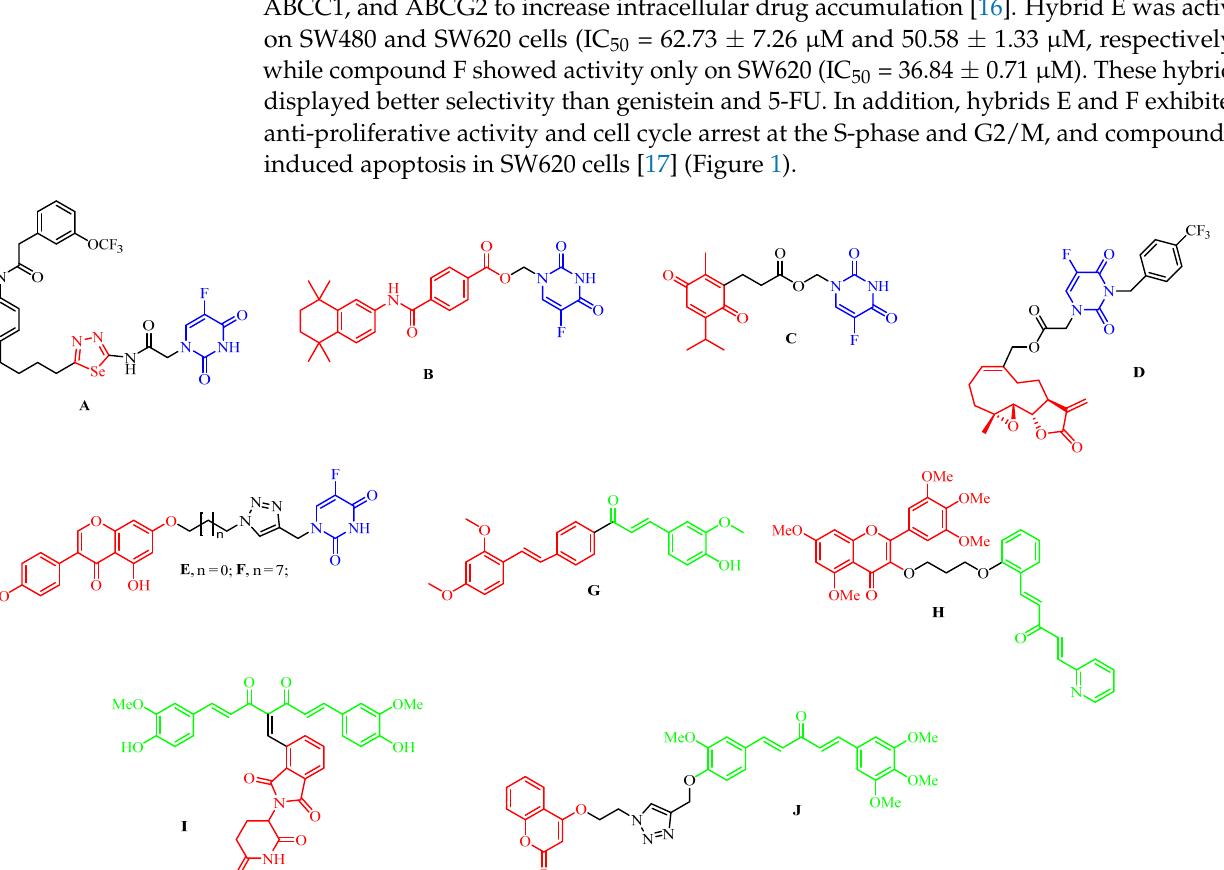
Figure 2. Design of 5-FU-Curcumin hybrids. 2. Materials and Methods 2.1. Chemical Synthesis 2.1.1. General Remarks Microwave reactions were carried out in a CEM Discover microwave reactor in sealed vessels (monowave, maximum power 300 W, temperature control by an IR sensor, and